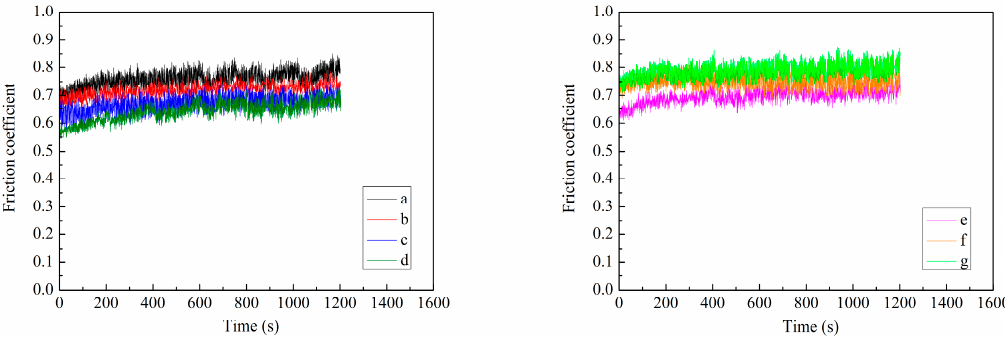
Figure 13. Friction coefficient of the microarc oxidation coatings formed on aluminum alloys at different anode pulse-widths. (a): 1000 μ s; (b): 1500 μ s; (c): 2000 μ s; (d): 2500 μ s; (e): 3000 μ s; (f): 3500 μ s; (g): 4000 μ s.